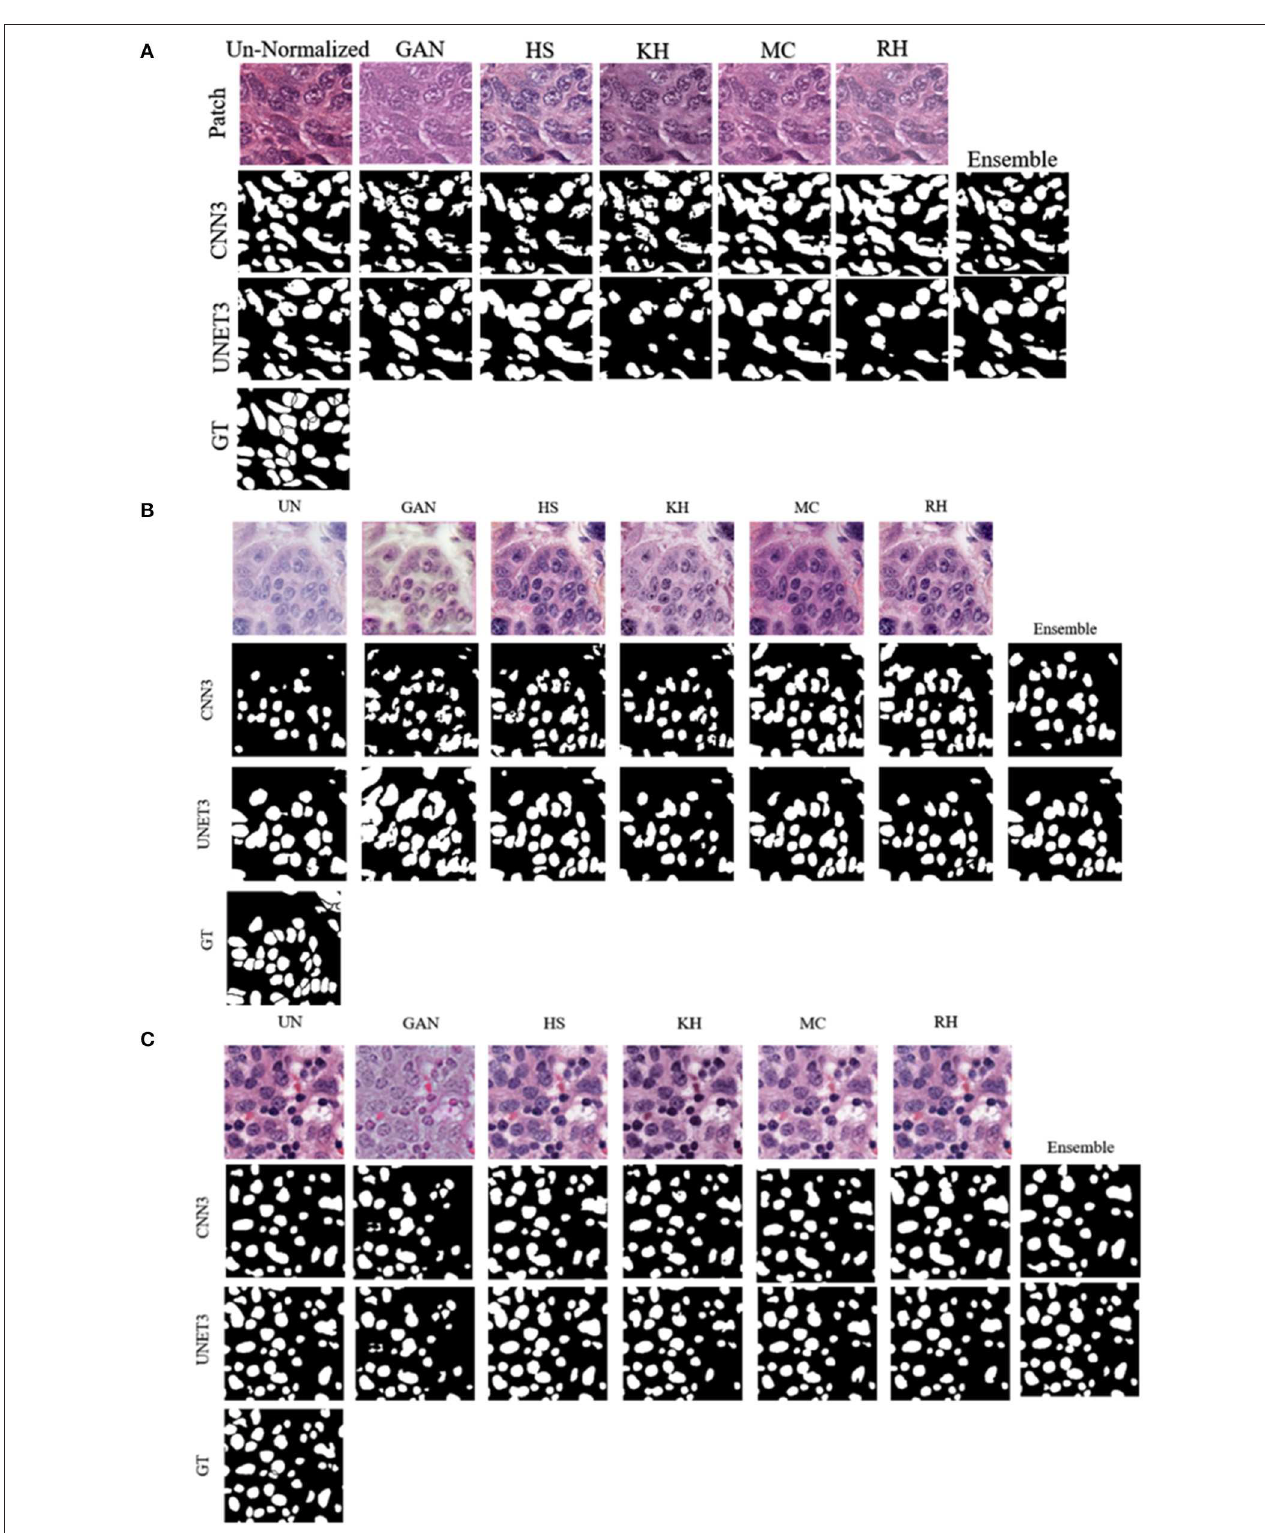
FIGURE 8 | Sample segmentation result across all datasets (A) TCGA-Kumar (B) TNBC (C) SMH-seg.